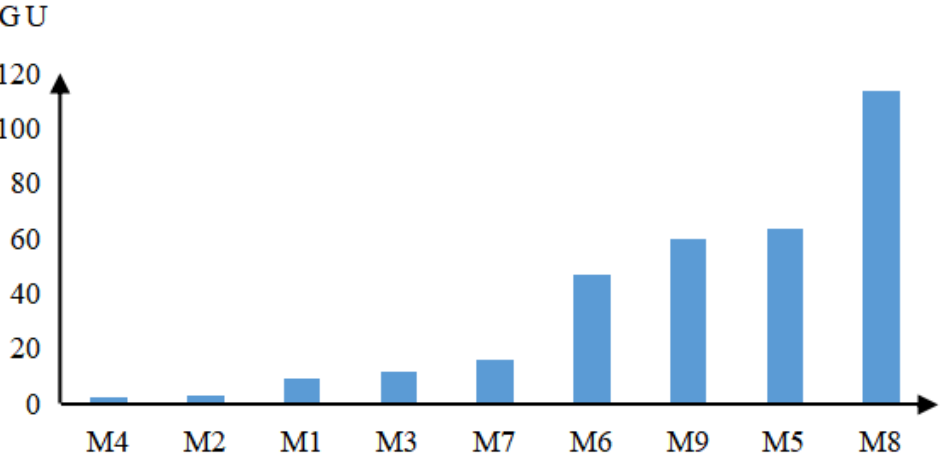
Figure 9. Material surface gloss (M1: Joinery board, M2: PVC board, M3: Fireproof board, M4: Solid wood board, M5: Painted solid wood board, M6: Melamine board, M7: Painted board, M8: Blister board, M9: Quartz board).